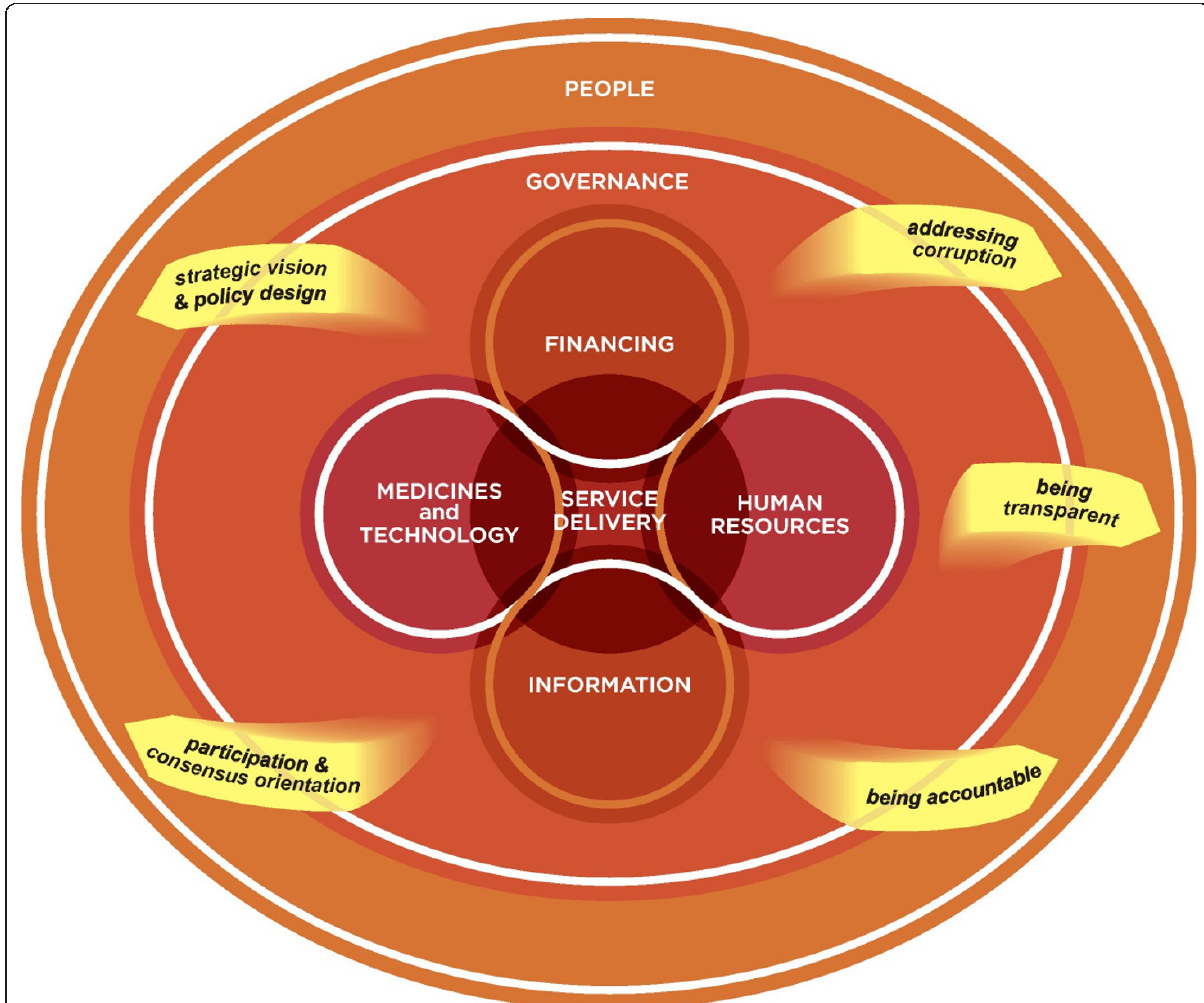
Figure 2 Assessing governance across the health system . Note: ‘ strategic vision & policy design ’ and ‘ participation & consensus orientation ’ can be viewed more conventionally as governance inputs, whilst ‘ addressing corruption ’ , ‘ being transparent ’ , and ‘ being accountable ’ are more governance